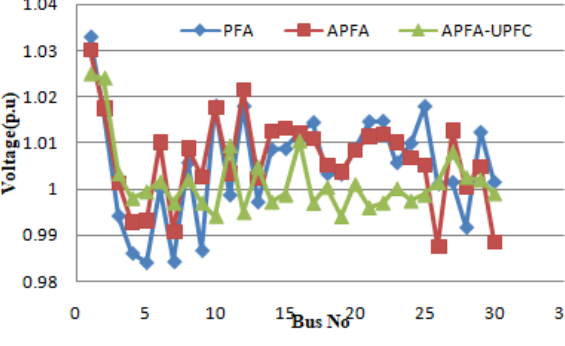
Figure 4. Bus voltages for different OPF techniques